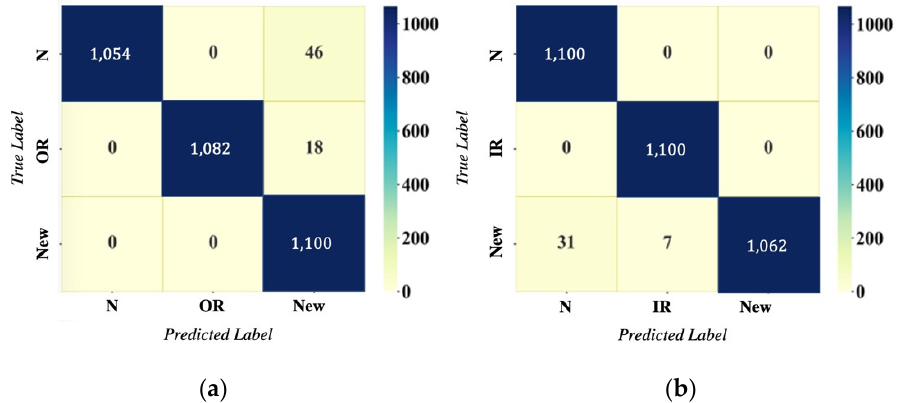
Figure 3. Confusion matrix of feature transferring from CWRU to Ottawa. ( a ) Hidden the labels of inner race faults (IR). ( b ) Hidden the labels of outer race faults (OR).